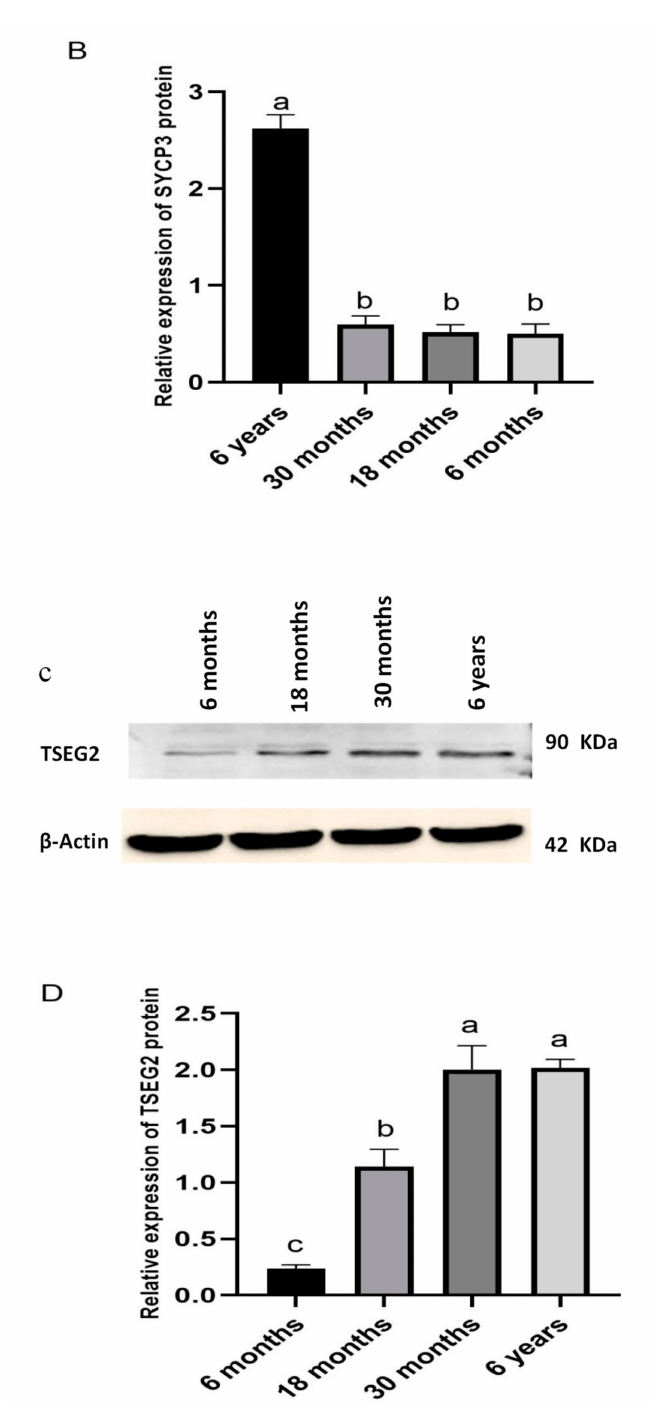
Figure 8. Characterization of SYCP3 and TSEG2 proteins in the testis of Yak. ( A ) Western blot results of SYCP3. ( B ) Relative expression of SYCP3 protein. ( C ) Western blot results of TSEG2. ( D ) Relative expression of TSEG2 protein from testes, while Beta actin was used as control. Protein levels were quantified by densitometric analysis. Di ff erent letters indicate significant di ff erence ( p <